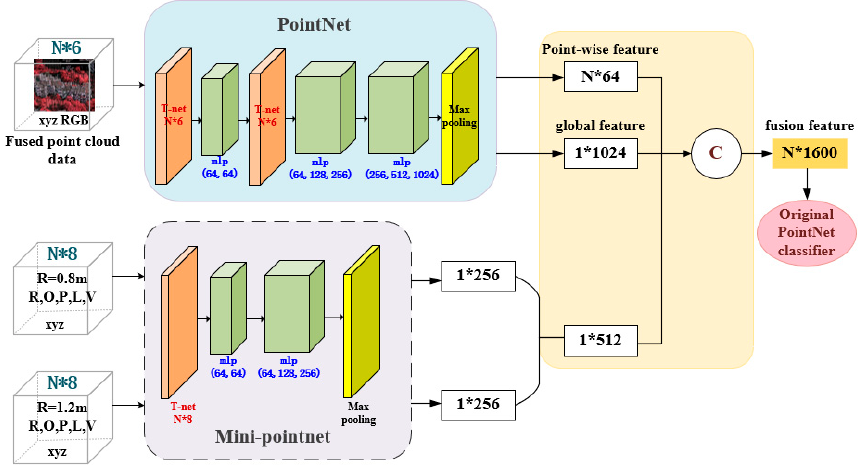
Figure 2. Architecture of MSMF-PointNet. (R = 0.8 m and R = 1.2 m: the radius of the spherical neighborhood is 0.8 and 1.2 respectively; R, O, P, L, and V: roughness, omnivariance, planarity, linearity, and verticality).